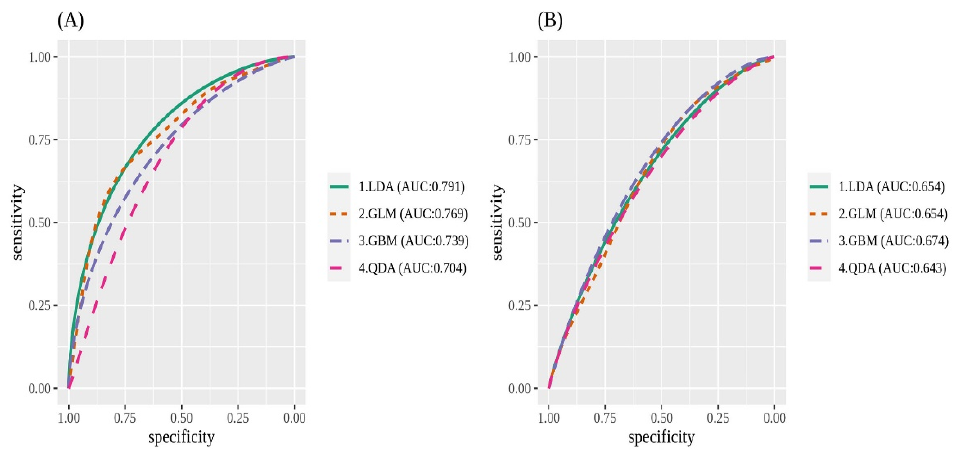
Figure 3. Differences in the area under the curve (AUC) based on whether ( A ) replacement driver variable was used or ( B ) not.